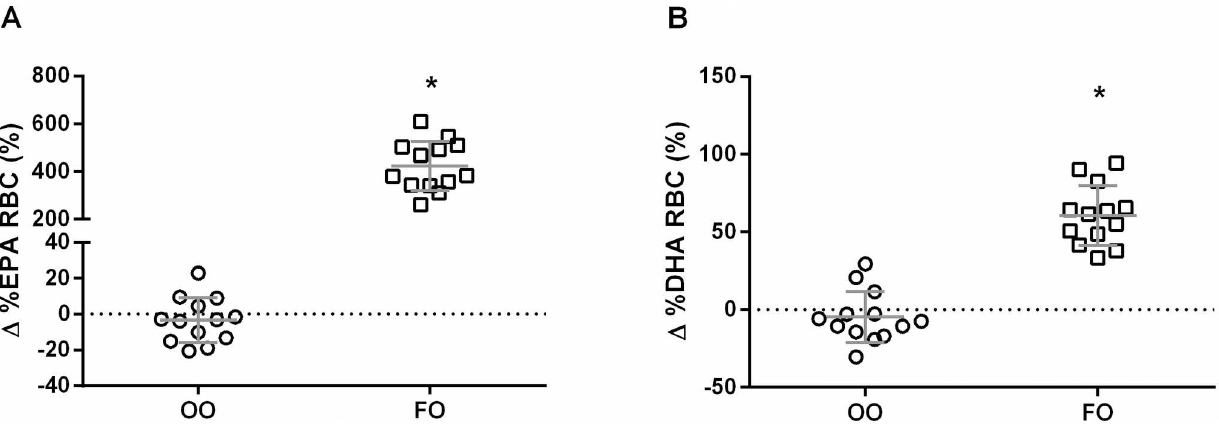
Fig 2. Percent (%) increasein red blood cell (RBC) levels of EPA (A) and DHA (B) in olive oil (OO) and fish oil (FO) groups after 12 weeks of supplementation. Valuesare reported as means ± SD. * FO group means were significantly different from the baseline(p <